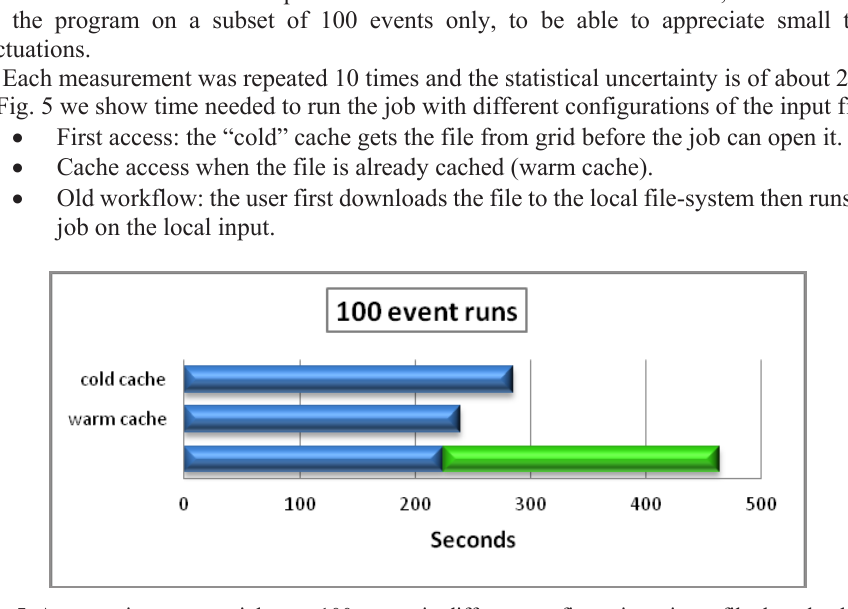
Fig. 4. Transfer time for files of different sizes (average values, statistical uncertainty ~5%) Fig. 5. Average time to run a job over 100 events in different configurations: input file